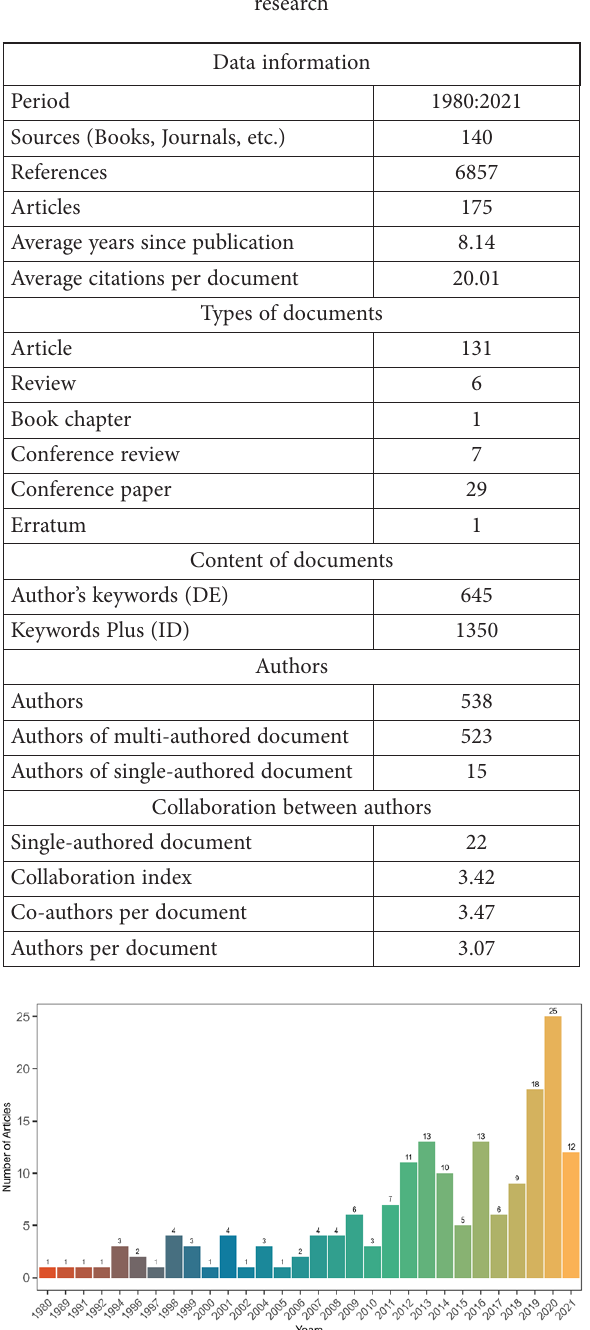
Table 1. Data information of publications in AI and PM